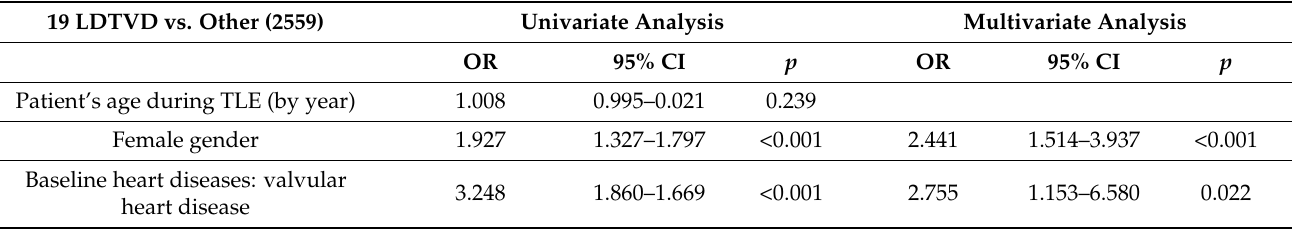
Table 6. Factors connected with LDTVD presence. Results of uni- and multi-variable logistic regression